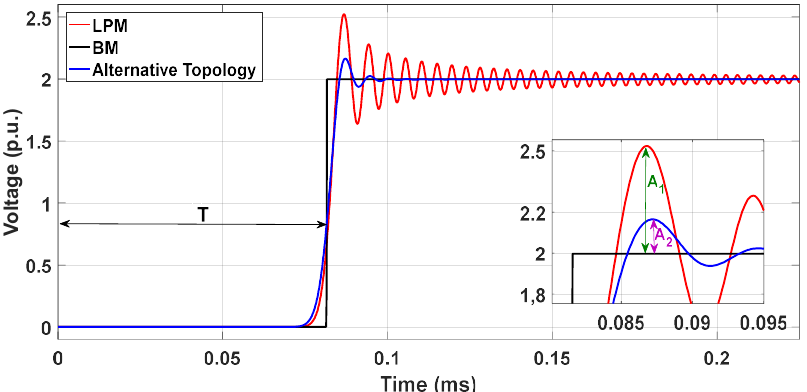
Figure 3. Voltages with different TL